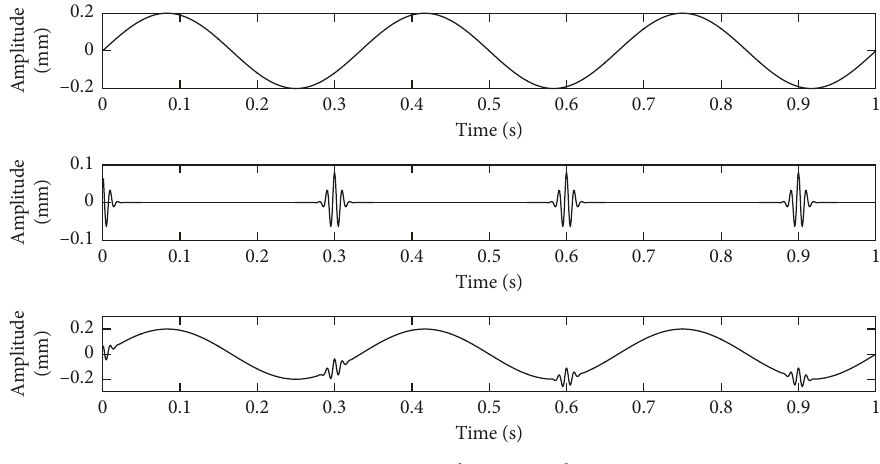
Figure 1: Simulation signal.